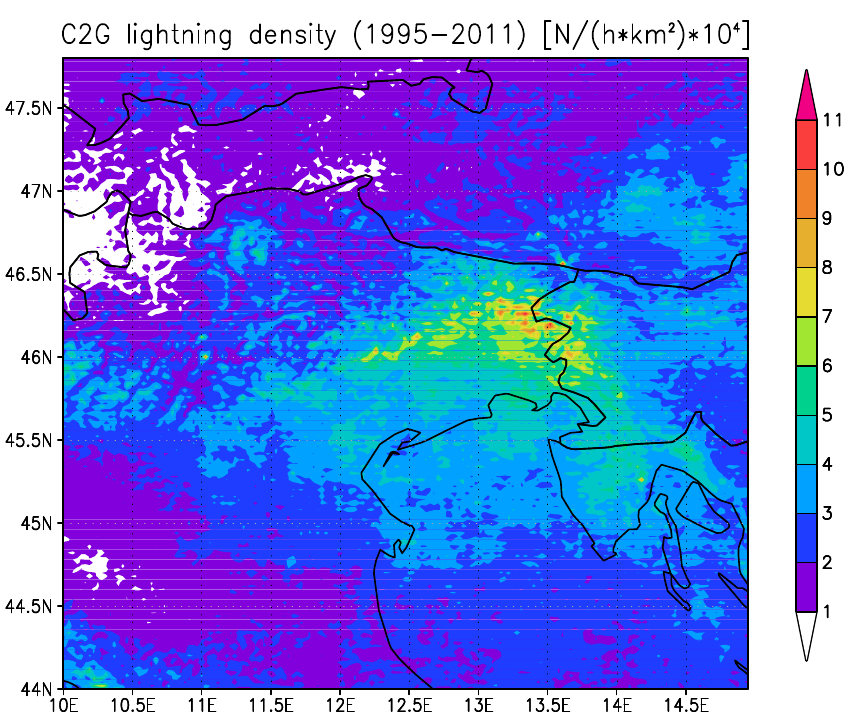
Figure 3. Spatial distribution on a grid of 0 . 03 × 0 . 02 degrees of resolution of the average number of C2G lightning per hour per km 2 computed for the 17–year period 1995–2011. The scale is multiplied by a factor of 10 4 .